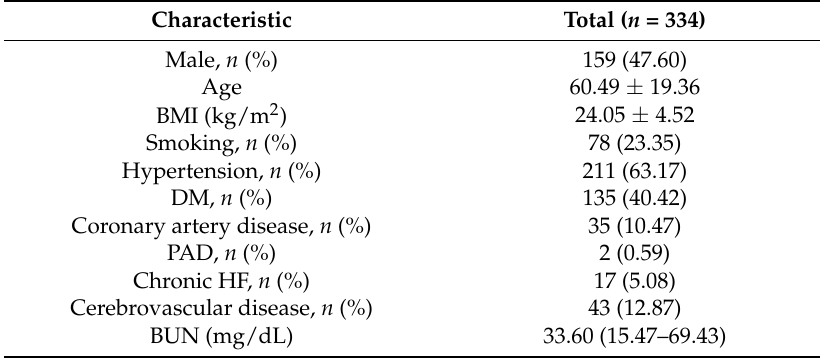
Table 1. Basal characteristics of 334 pre-dialysis CKD patients.